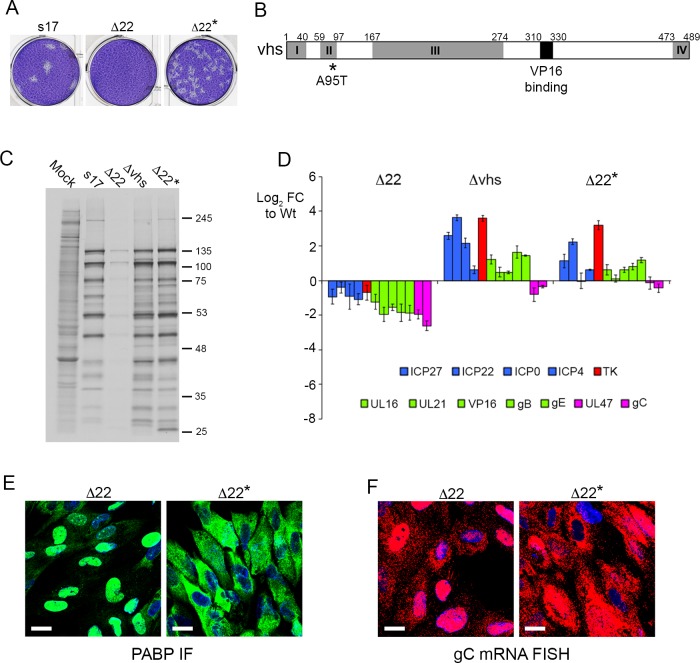
Translational arrest and nuclear retention of late virus transcripts is rescued by mutation of vhs in Δ22 infection.(A) Plaque formation of a spontaneous variant of the Δ22 virus (Δ22*) in comparison to Wt and Δ22 on HFFF cells. (B) Line drawing of the HSV-1 vhs open reading frame denoting the 4 conserved boxes (I to IV) and the VP16 binding domain. Sequencing of the vhs gene from the Δ22* genome revealed a single amino acid change in the second conserved box of the protein (A95T). (C) HFFF cells were infected with Wt (s17), Δ22, Δvhs or Δ22* viruses at a multiplicity of 2, were metabolically labelled with [35S]-methionine 15 hours after infection. Cells were lysed and analysed by SDS-PAGE and autoradiography. (D) HFFF cells infected with Wt (s17), Δ22, Δvhs or Δ22* viruses at a multiplicity of 2 were harvested for total RNA at 16 hours and analysed by qRT-PCR of the indicated virus transcripts. Results are represented as Log2 fold change to Wt (ΔΔCT), and the mean ± standard error for n = 3 is shown. Transcripts are colour-coded as blue (immediate-early) red (early), green (late) and pink (true late). (E) & (F) HFFF cells infected with Δ22 or Δ22* viruses at a multiplicity of 2 were fixed at 16 hours and subjected to PABP immunofluorescence in green (E) or multiplex mRNA FISH with probe specific for the late transcript gC in red (F). Nuclei were counterstained with DAPI (blue). Scale bar = 20 μm.